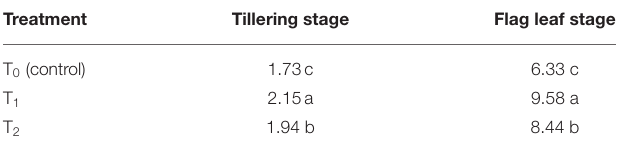
TABLE 1 | Effect of cytokinin producing Azospirillum brasilense RA − 17 (T 1 ) and non-producing A. brasilense RA − 18 (T 2 ) on crop growth rate (CGR, g m − 2 day − 1 ) of wheat.